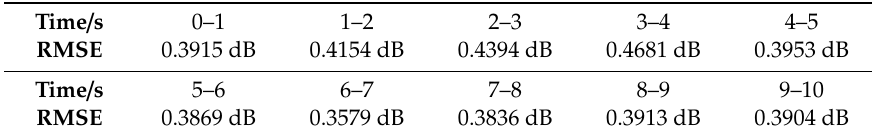
Table 2. RMSE of ten data segments.